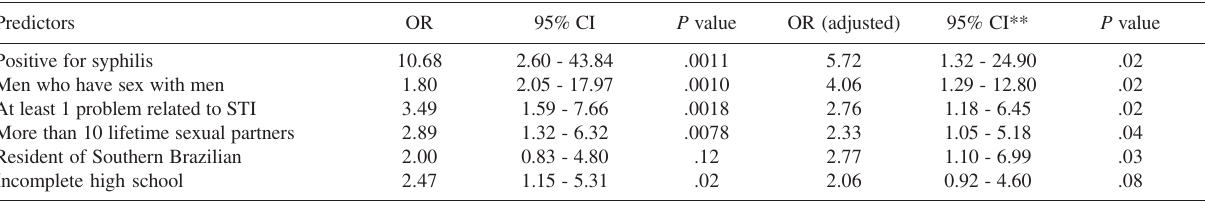
Table 6 - Predictor factors for HIV infection. Brazilian Army conscripts, 2002 Predictors OR 95% CI P value OR (adjusted) 95% CI** P value Positive for